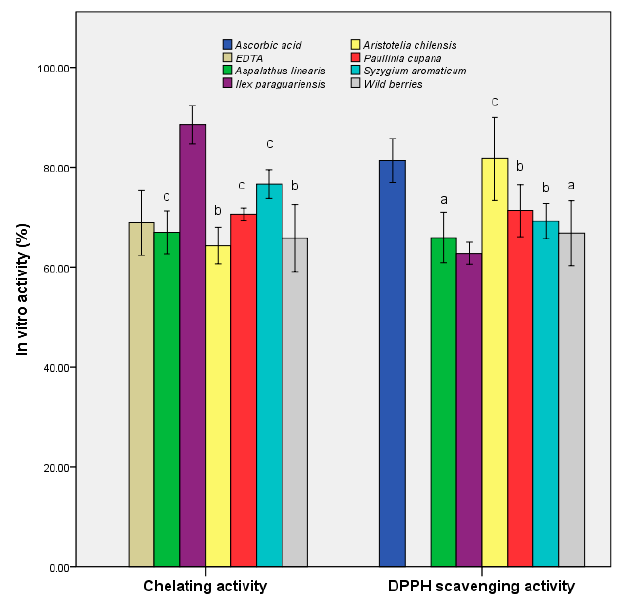
Figure 3. In vitro antioxidant activities of the samples. Di ff erent letters represent significant statistical di ff erences (EDTA / ascorbic acid vs. samples; p ≤ 0.05), n = 3; EDTA / ascorbic acid was used as control.